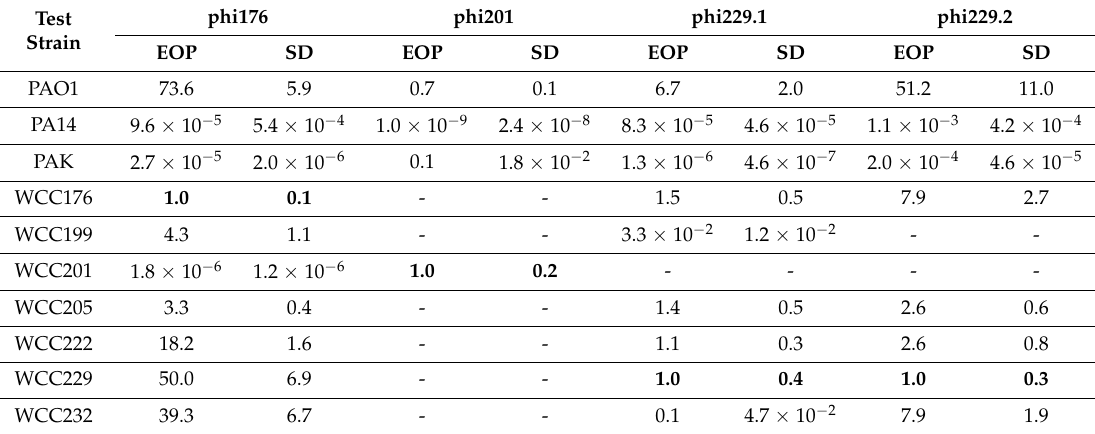
Table 4. Efficiency of plating (EOP) and standard deviations (SD) of phages isolated on clinical isolates. ‘-’ indicates no plaques (<10 pfu/mL). EOP is determined as the phage titer on a test strain divided by the titer of the same phage preparation on the isolation host. EOP and SD values on the isolation strains are shown in